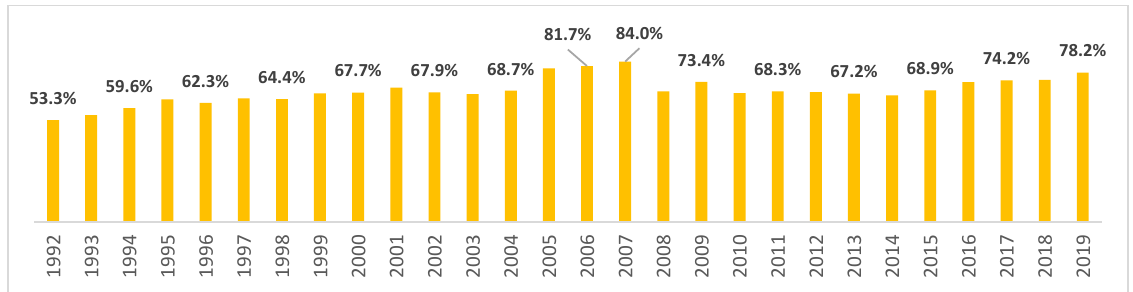
Fig. 1. Bank Credit to Private Sector to GDP